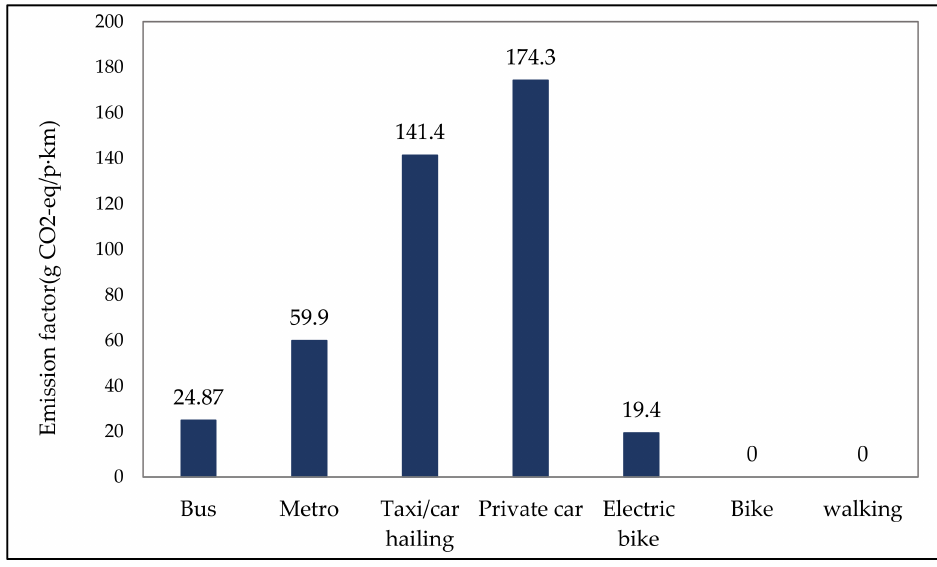
Figure 2. The GHG emission of different transport modes during the use